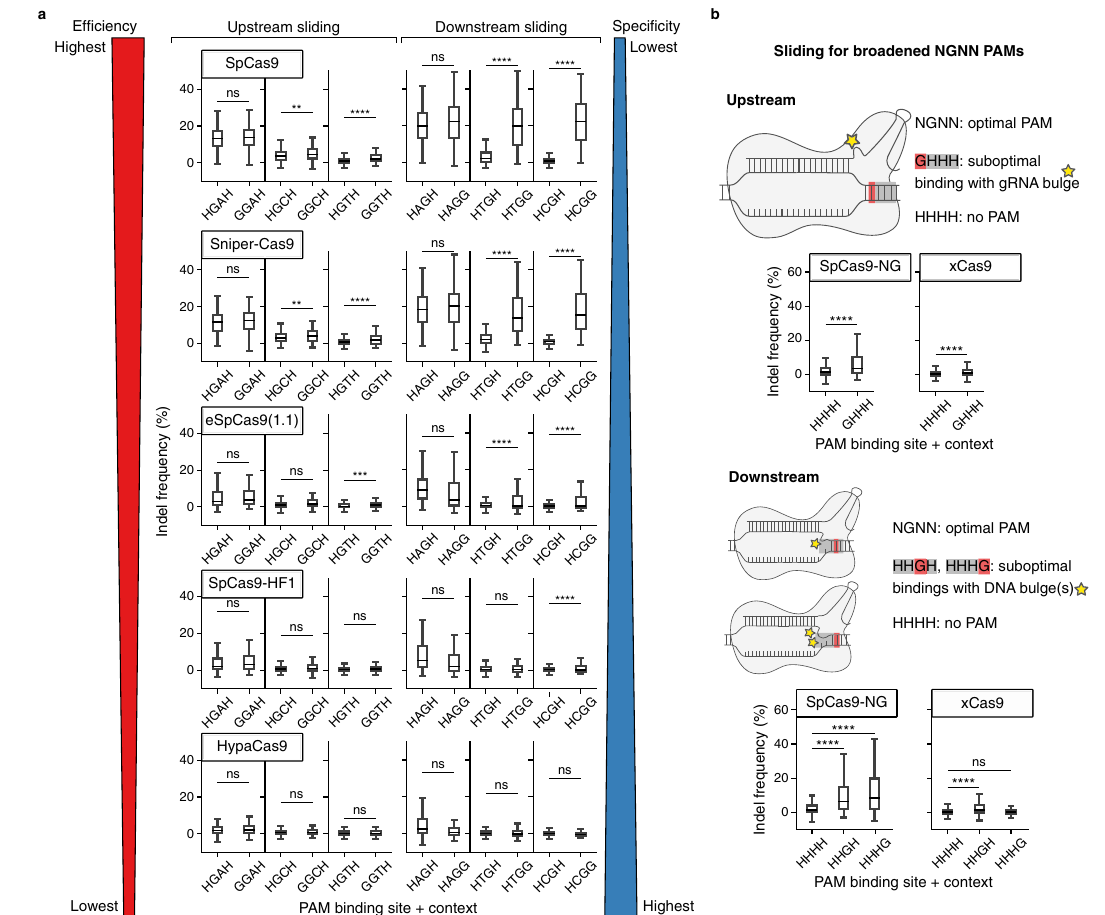
Fig. 5 Sliding affects PAM recognition by Cas9 variants. a Boxplots of indel frequencies produced by Cas9 variants in HEK293T cells at targets followed by different PAMs (X-axis). Each row represents a Cas9 variant, sorted from top to bottom by ef fi ciency and inverse speci fi city. Boxplots are separated in two groups for upstream (left) and downstream (right) sliding. Boxes represent the fi rst and third quartiles (Q1 and Q3). The median is shown as a line; whiskers extend up (or down) to the last (or fi rst) value lower (or greater) than Q3 + 1.5*(Q3-Q1) (or Q1-1.5*(Q3-Q1)). One-sided t -test p values, Bonferroni-corrected by the number of Cas9 variants: from left to right, top to bottom: 1.00; 4.90E-03; 4.15E-09; 0.06; 9.60E-49; 5.53E-84; 0.83; 8.44E- 03; 2.43E-07; 0.40; 1.03E-39; 1.78E-63; 1.00; 0.09; 6.87E-04; 1.00; 5.54E-06; 1.08E-12; 0.85; 0.32; 0.13; 1.00; 0.078; 1.16E-05; 0.71; 0.71; 0.32; 1.00; 0.59; 0.06. The alternative hypothesis is that gRNA ef fi ciencies at targets with G − 1 (left) or G + 1 (right) have larger mean, respectively, than targets with H − 1 or H + 1 . Number of elements in each box, from left to right, top to bottom: 265; 88; 261; 85; 267; 85; 263; 88; 260; 86; 265; 86; 265; 88; 262; 86; 267; 85; 264; 264; 88; 260; 87; 264; 86. b Illustration of the sliding mechanism at N − 1 GNN + 1 PAMs, and boxplots of indel frequencies in HEK293T cells produced by Cas9 variants with broadened PAM compatibility at targets with different PAMs (X-axis). Boxes are de fi ned as in ( a ). One-sided t -test p values, Bonferroni- corrected by the number of Cas9 variants: from left to right, top to bottom: 2.30E-59; 8.68E-25; 2.12E-135; 1.94E-186; 7.06E-69; 1.00. The alternative hypothesis used is that gRNA ef fi ciencies at GHHH (upstream case) or HHGH/HHHG (downstream case) targets have larger mean than at HHHH. Number of elements in each box, from left to right, top to bottom: 2322; 799; 2317; 778; 2322; 786; 772; 2317; 786; 770. Source data are provided as a Source Data fi